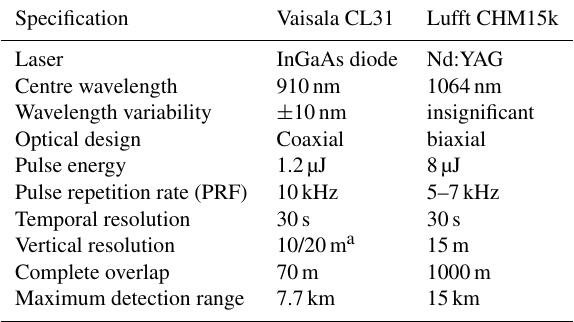
Table 1. Summary of some technical characteristics and parameters of the Vaisala CL31 and Lufft CHM15k, as operated in the Met Office